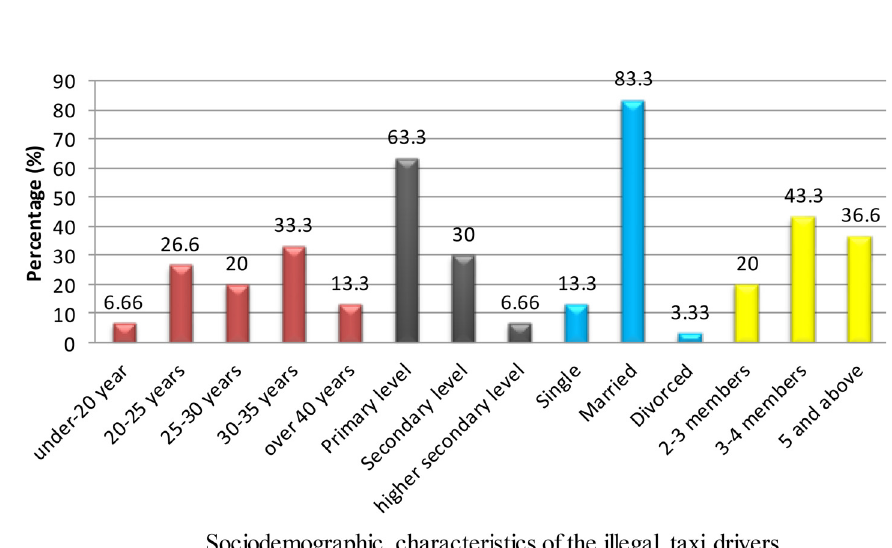
Table VI. Result of regression analysis of E-taxi service quality